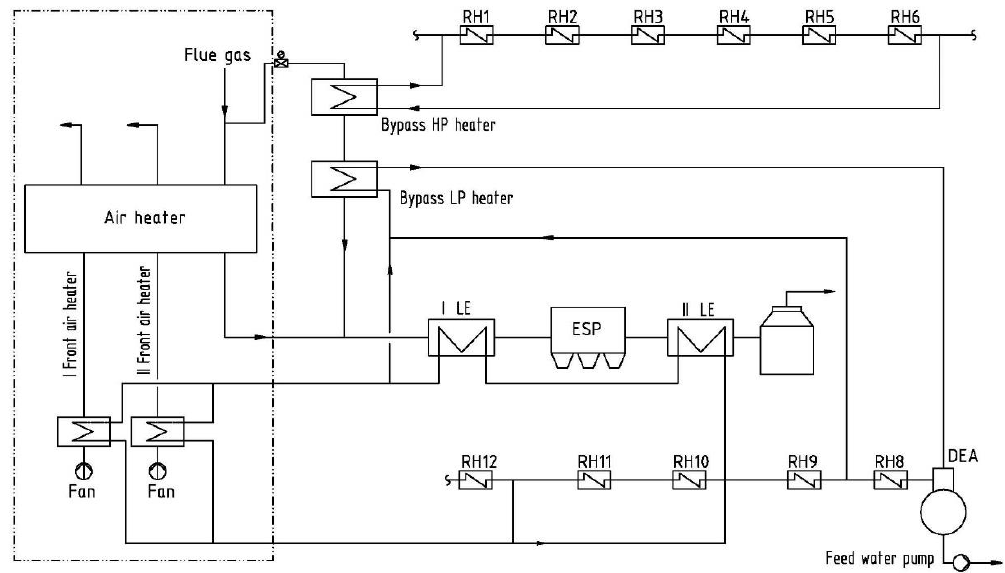
Figure 3. Furnace-coupled multi-level cascade utilization system.